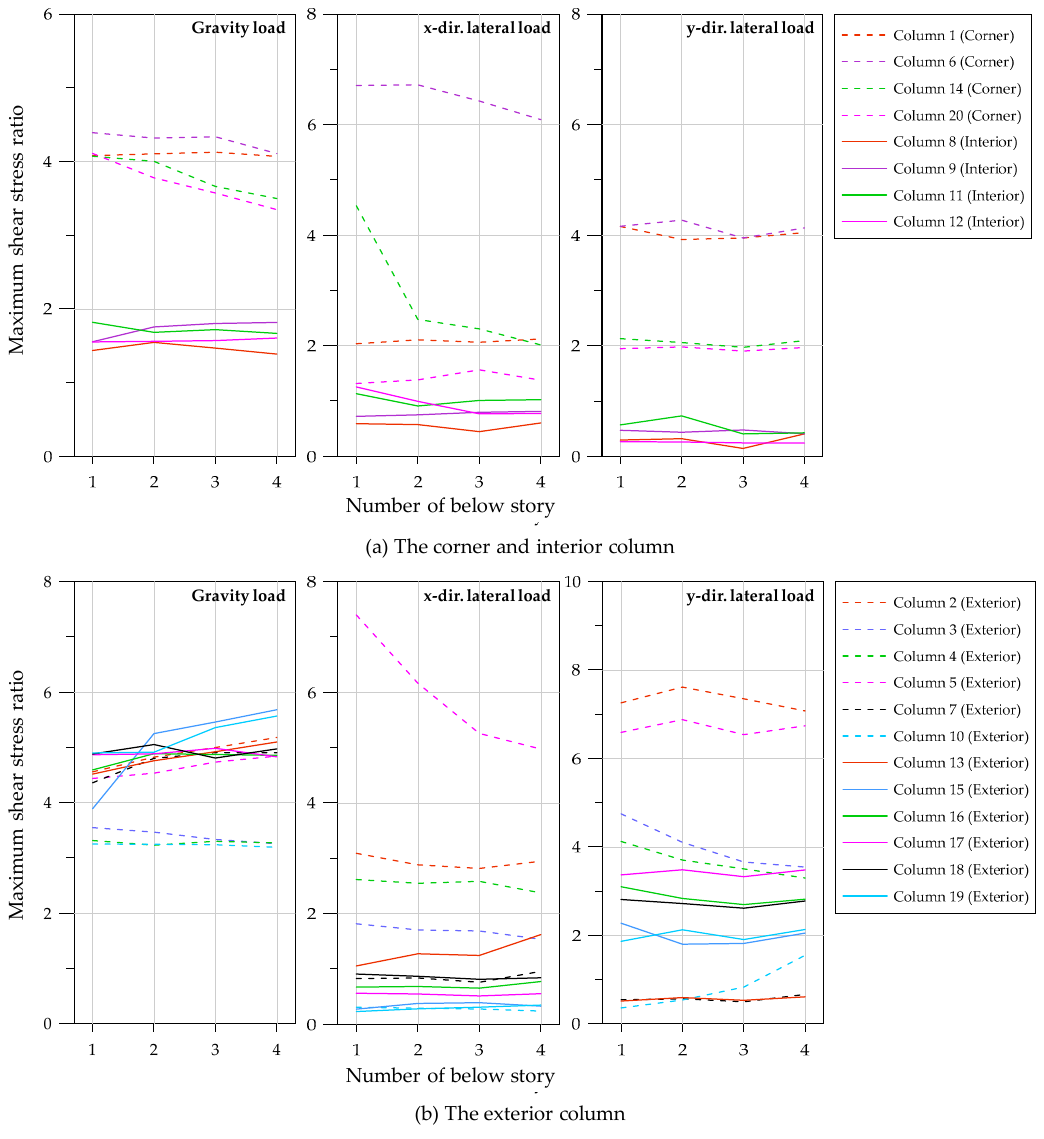
Figure 18. Maximum shear stress ratio vs. number of stories below (Flat-shape plan). ( a ) Corner and interior columns and ( b ) Exterior